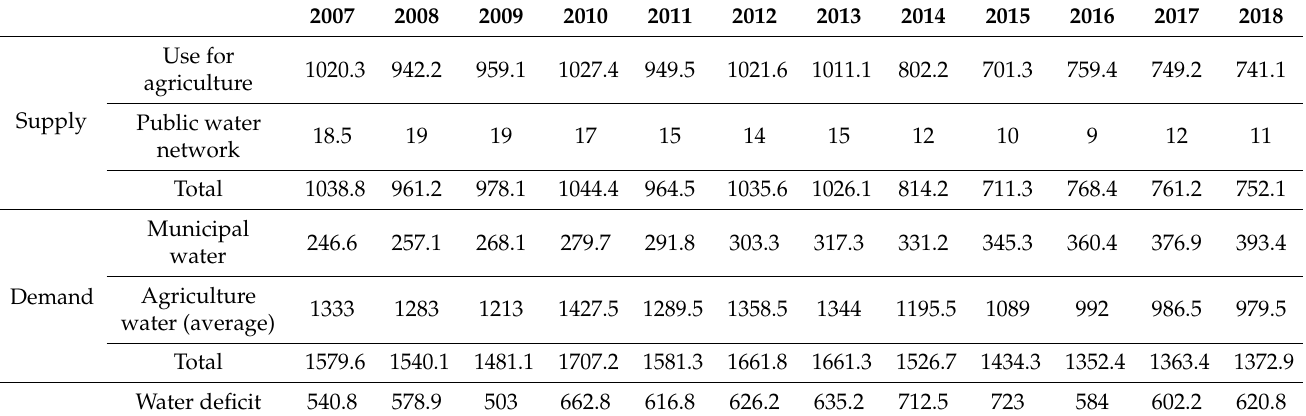
Table 2. Water supply and demand estimated for Sana’a region. Units: Mm 3